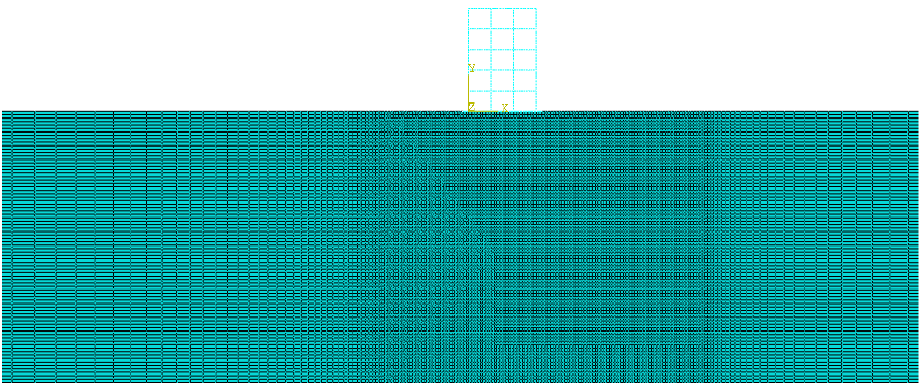
Fig 5. An example of meshing of soil layers and adjacent building in ABAQUS